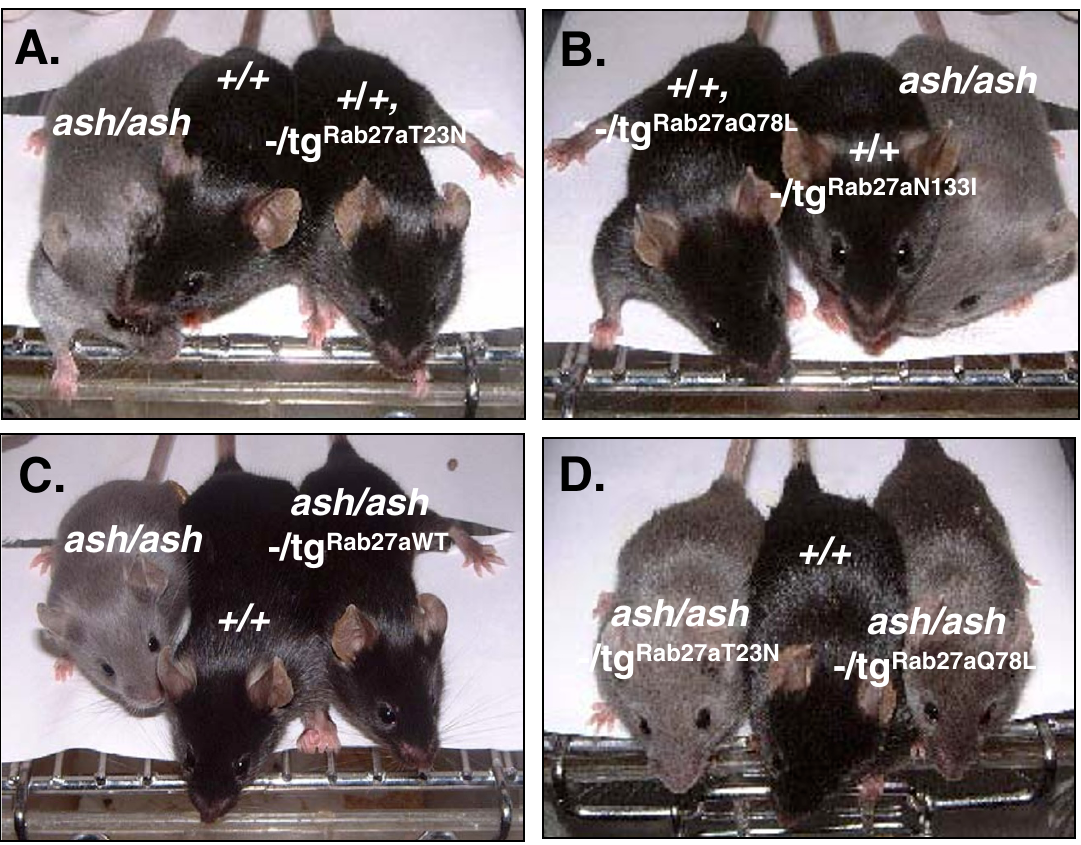
Figure 6 Photographs of representative transgenic and mutant mice. +/+, wild type C57BL/6J mouse; ash/ash , homozygous Rab27a ashen mutant mouse; -/tg, heterozygous transgenic of the indicated